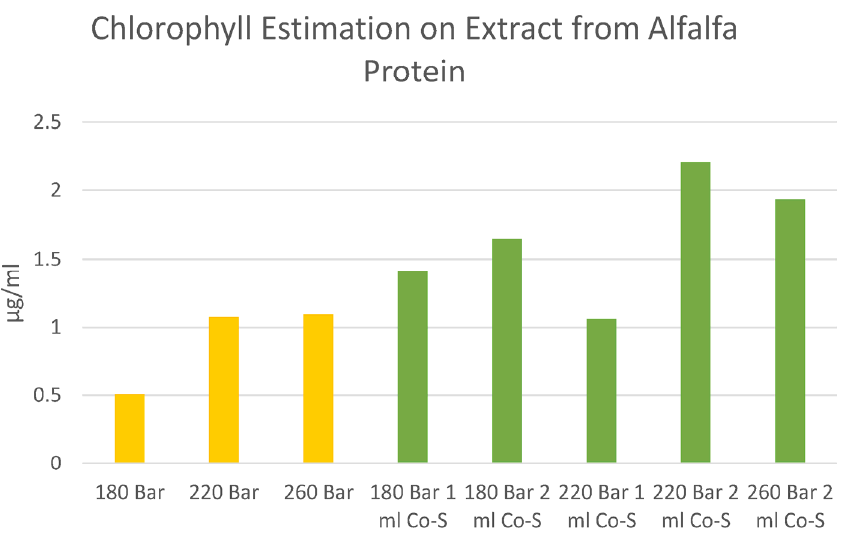
Figure A2. Chlorophyll concentration in the extract from supercritical CO 2 extraction of alfalfa protein. Yellow bars were run without co-solvent and had none to mild grass aromas, green bars were run with co-solvent and all had a strong grass aroma.